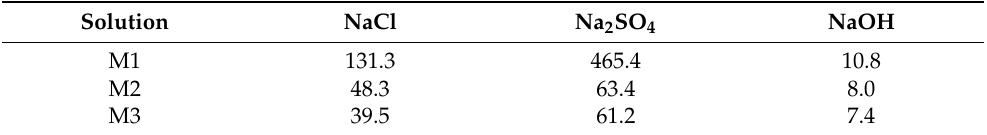
Table 7. Maximum values of cathodic current densities of polarization curves under three measuring methods in the neutral and alkaline solutions ( µ A · cm − 2